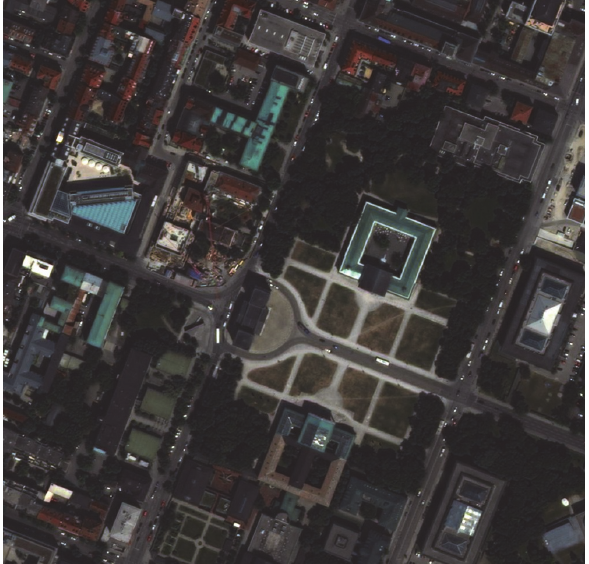
Figure 5. Reconstruction using spectral unmixing model (29).